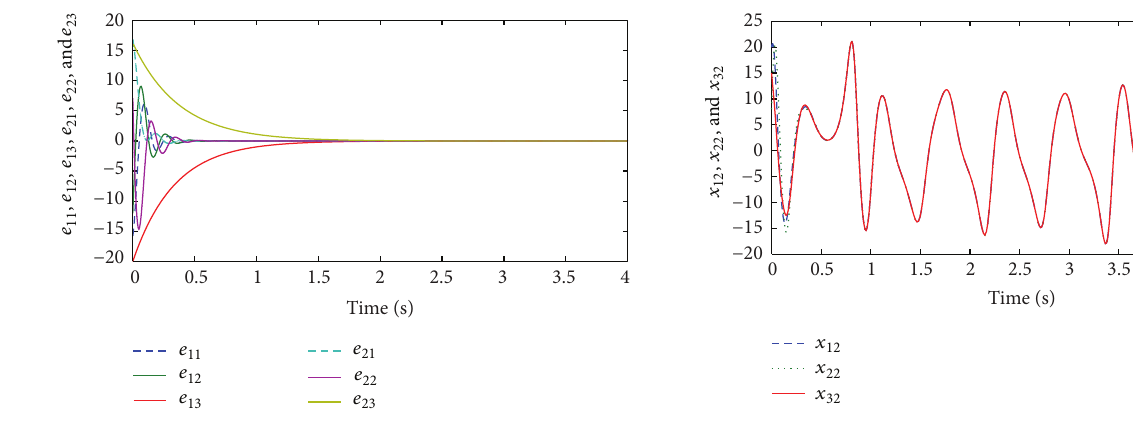
Figure 5: Dynamics of the variables 𝑒 11 , 𝑒 12 , and 𝑒 13 of the error sys- tem 𝑒 1 with time 𝑡 .